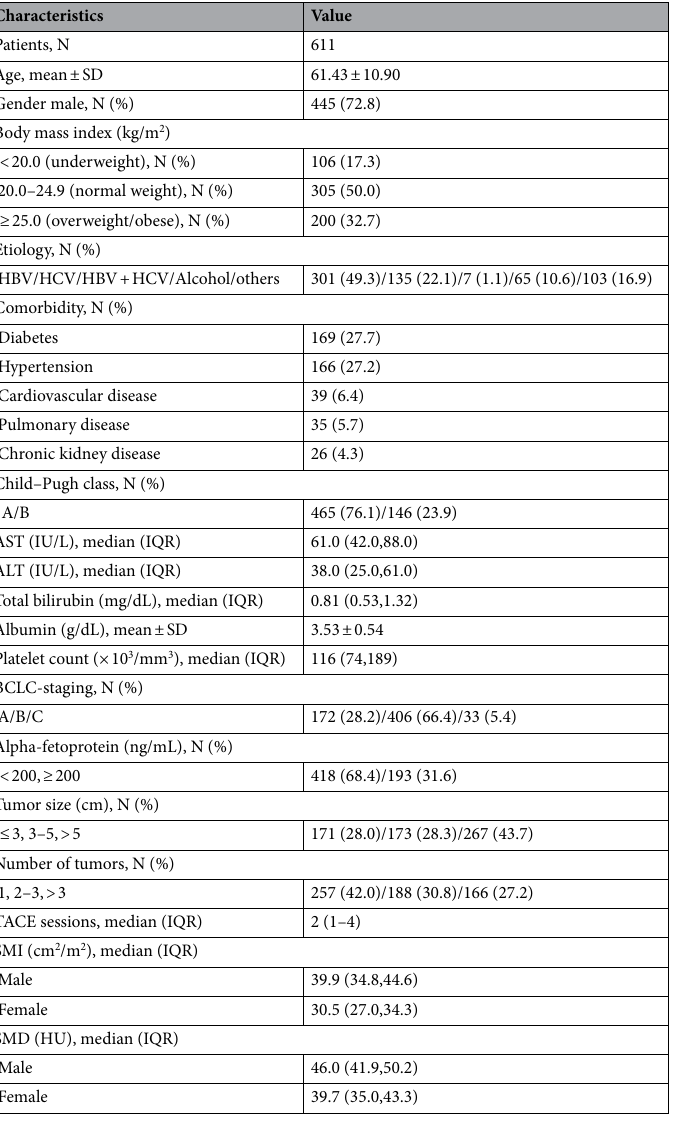
Table 1. Baseline characteristics of the study participants who underwent TACE. SD standard deviation, IQR interquartile range, HBV hepatitis B virus, HCV hepatitis C virus, AST aspartate transaminase, ALT